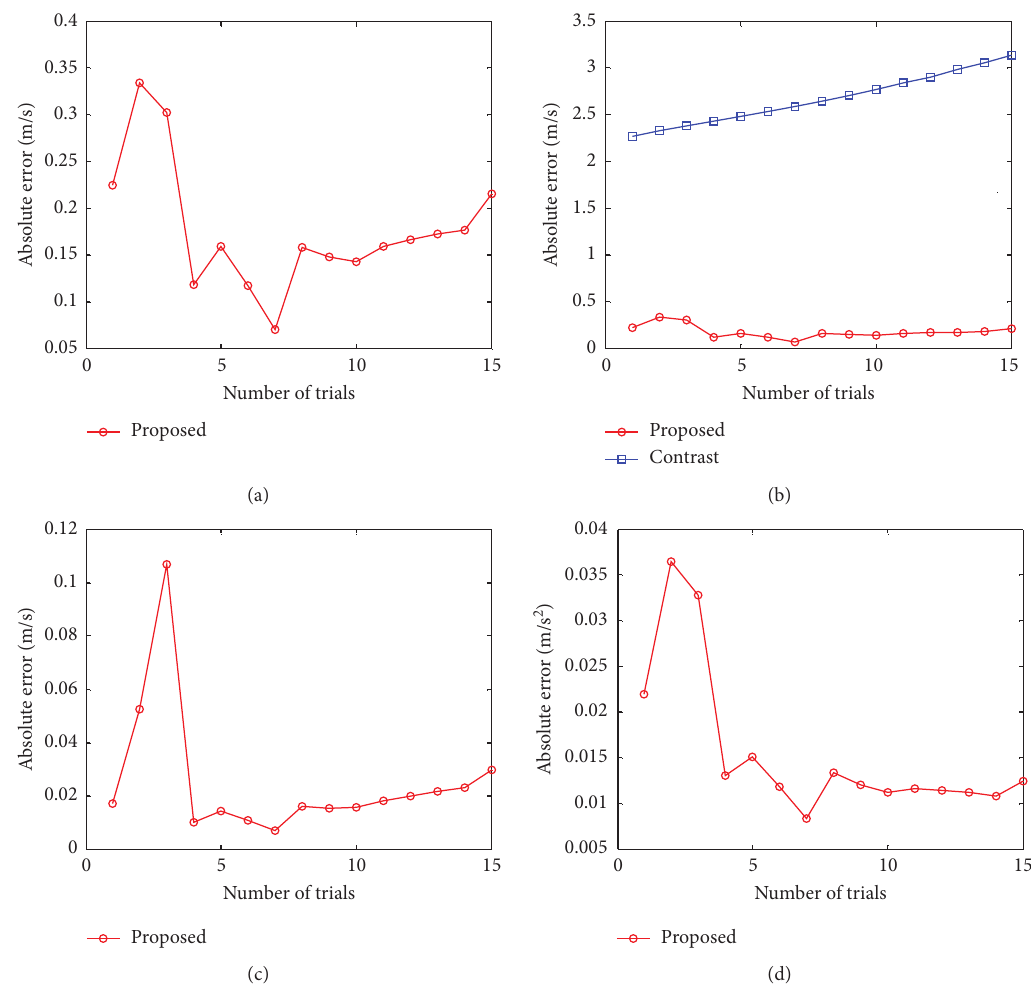
� 4 m/s and a � 0.1m/s 2 . (a) Absolute y 0 y 0